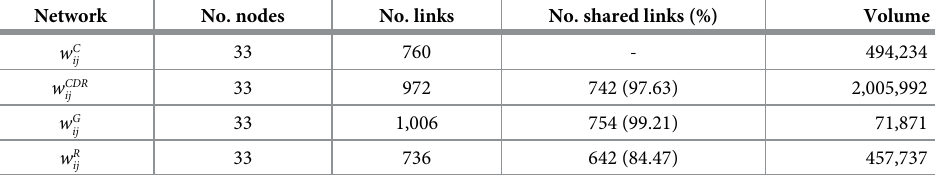
Table 1. Basic properties of the mobility networks. The table reports the total number of nodes and links, the number of links shared with the census network, and the total volume of travellers of each mobility network under study. Self- loops are excluded.